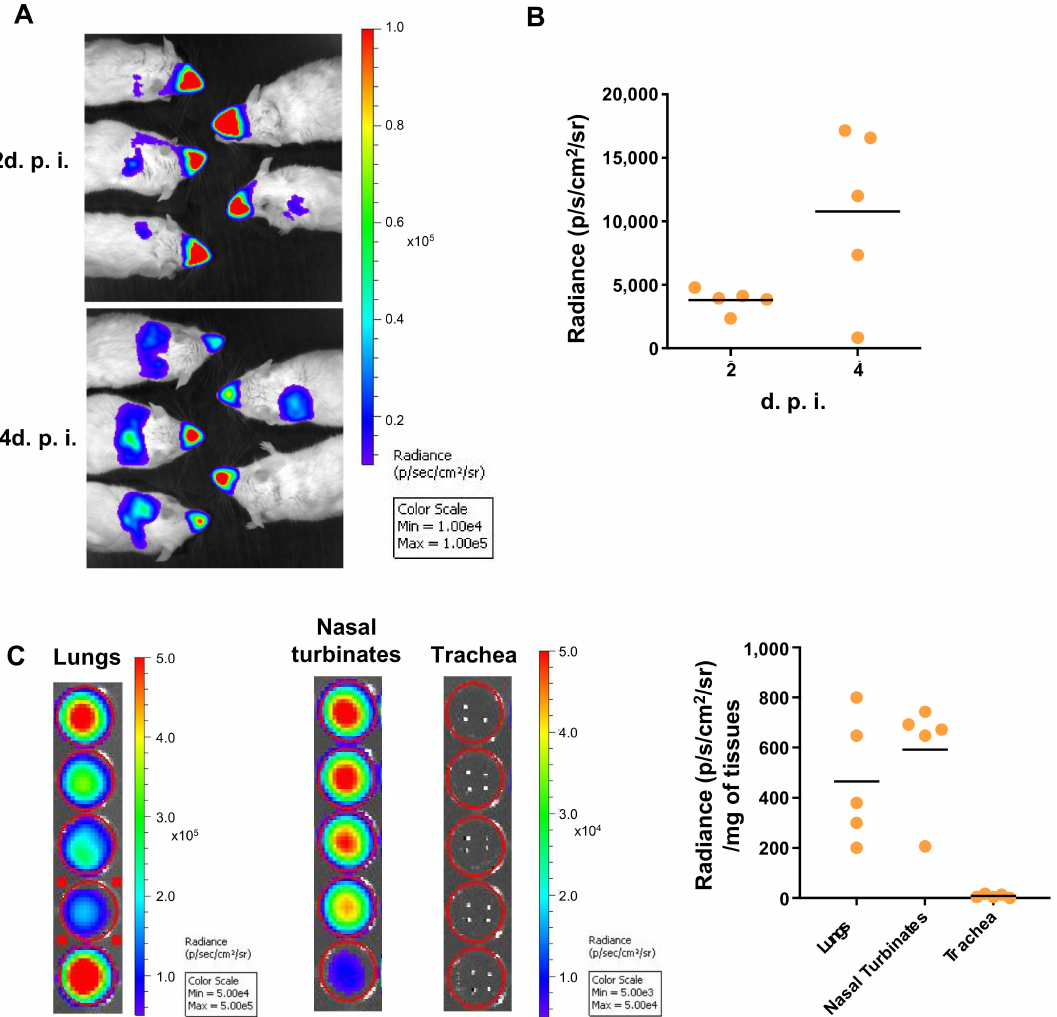
Figure 1. RSV replication in whole BALB/c mice. Adult BALB/c mice were intranasally infected with rHRSV-Luc. ( A ) At 2- and 4-days post-infection (d.p.i.), mice intranasally received luciferin (1.5 mg under 50 µ L), and luciferase activity was visualized in the IVIS-200 imaging system. Images make it possible to observe virus replication in the nose and the lungs of animals at 2- and 4- days post-infection. The scale on the right indicates the average radiance: the sum of the photons per second from each pixel inside the region of interest/number of pixels (p/s/cm2/sr). A red signal indicates a high radiance, and consequently a high luciferase activity, whereas a blue signal indicates a low radiance, indicative of a low replication. ( B ) Quantification of luciferase activity in the lungs of living mice (radiance in photon/s/cm 2 /sr). ( C ) Quantification of luciferase activity in lungs, nasal turbinates (NT) or trachea homogenates. The scales indicate the average radiance: the sum of the photons per second from each pixel inside the region of interest/number of pixels (p/s/cm2/sr). Individual results were expressed radiance in photon/s/cm 2 /sr/mg of tissues and means are expressed as mean of individual ± SEM (one representative experiment of two with n = 5 to 8 mice/group) are represented ( n = 5